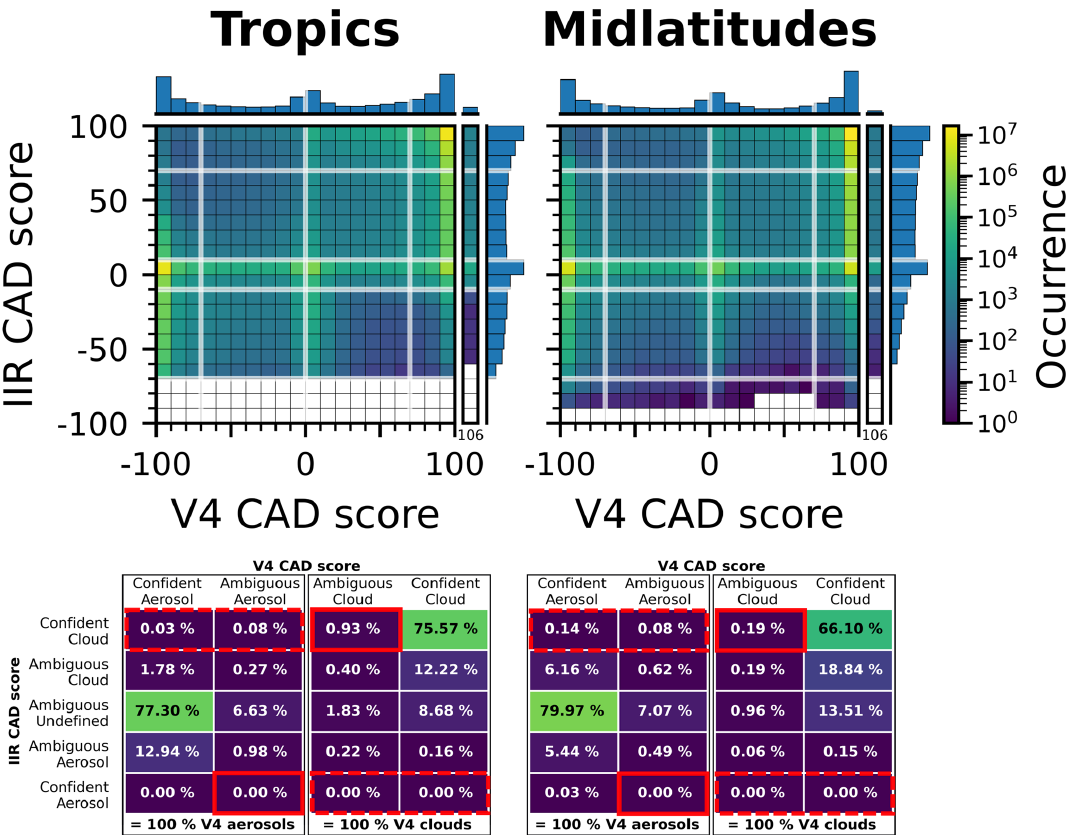
Figure 12. IIR CAD score vs. V4 CAD score for all monolayer observations for the 2008–2019 period. Transparent white lines show the limit between confident and ambiguous cases. 2-D and 1-D histograms are in log scale. Also shown is the special CAD score 106 (“cirrus fringes”) of the V4 classification shown here. Tables below plots provide the fraction of IIR confident ( | CAD score , V4 | > 70), ambiguous (10 < | CAD score , V4 | < 70), and undefined ( | CAD score , V4 | < 10) classifications of the V4 cloud and aerosol layers. Red rectangles show where the V4 CAD algorithm can benefit from IIR observations to confirm ambiguous cloud or aerosol layers (solid border line) and correct false cloud or aerosol detections (dashed border